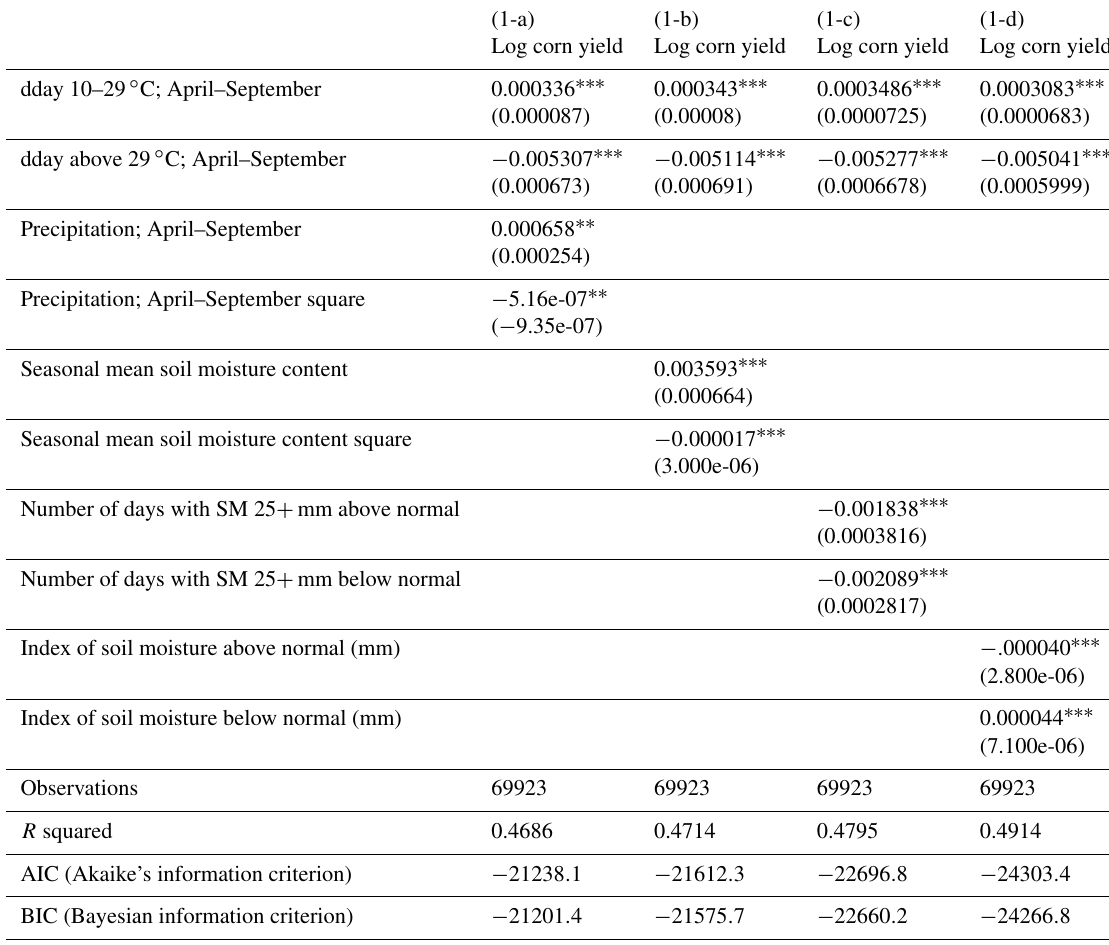
Table 2. Corn yield estimation without the interaction of heat and soil moisture in Models (1